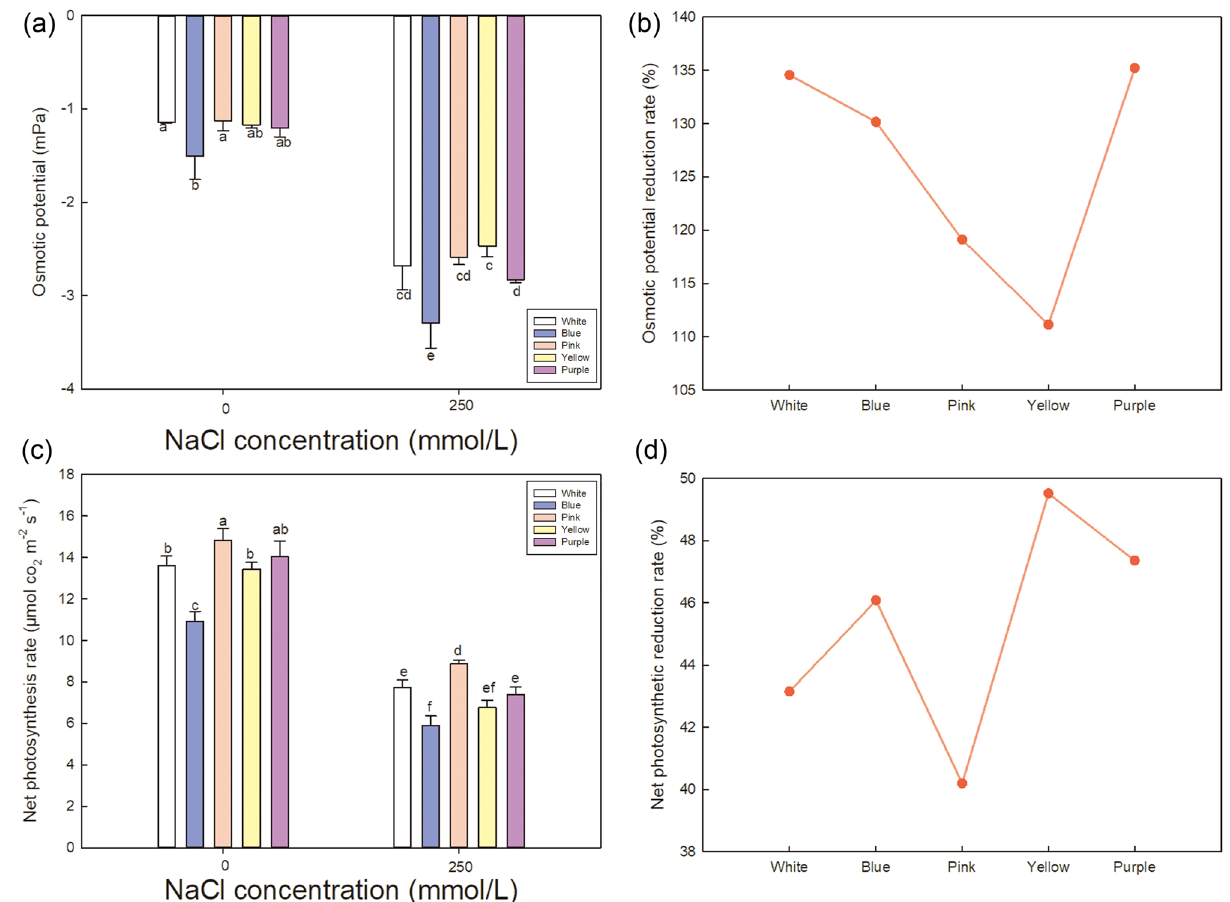
Figure 8. Effect of NaCl stress on the osmotic potential and net photosynthetic rate in the leaves of five varieties of Limonium sinuatum . ( a , c ) Osmotic potential and net photosynthetic rate under control and NaCl treatment. The data are means ± SD of five replicates. Different letters indicate significant differences between two groups at P = 0.05 using Duncan’s with SPSS. ( b , d ) The reduction rate of osmotic potential and net photosynthetic rate under NaCl treatment. The reduction rate was calculated as (the value under control—the value under NaCl treatment)/the value under control × 100%.